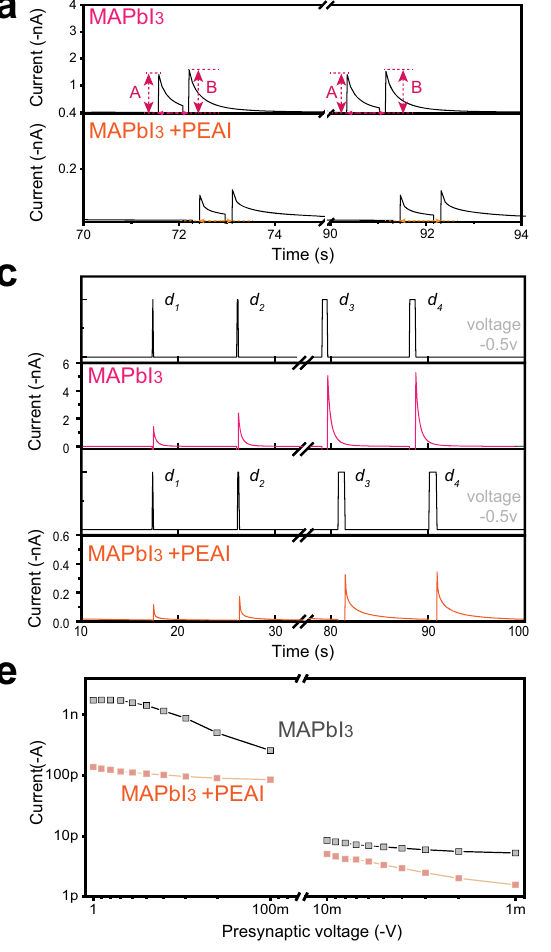
Fig.2|Short-termplasticityinRT-PVKarti fi cialsynapses.a EPSCtriggeredbya with or without PEAI passivation. Black: voltage spikes; pink and orange: response pair of spikes ( − 0.5V, 68ms) in perovskite arti fi cial synapse with/without PEAI currents of the devices. d SRDP behaviour of the device. Frequencies f 1 =1.06Hz, − 0.5V,68ms) e EPSC triggered by f passivation. b PPF index versus time interval in perovskite arti fi cial synapse with/ 2 =6.39Hz. Each group consisted of 10 spikes ( without PEAI passivation. c SDDP behaviour of the device. EPSC triggered by spikesatvariedvoltages( − 1to − 1000mV). f Cyclesofpotentiationanddepression consecutive spikes with different durations ( d 1 =68ms, d 2 =136ms, d 3 =545ms, in perovskite arti fi cial synapse with PEAI d − 0.5V) in RT-PVK arti fi cial synapse 4 =615ms) and the same voltage amplitude (